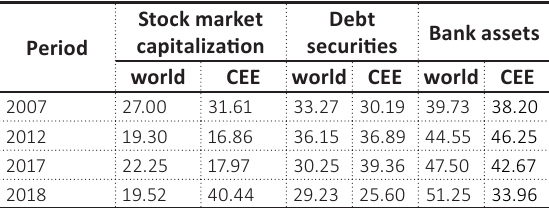
Table 2. Structure of financial assets of the world and the CEE countries in 2007–2018,